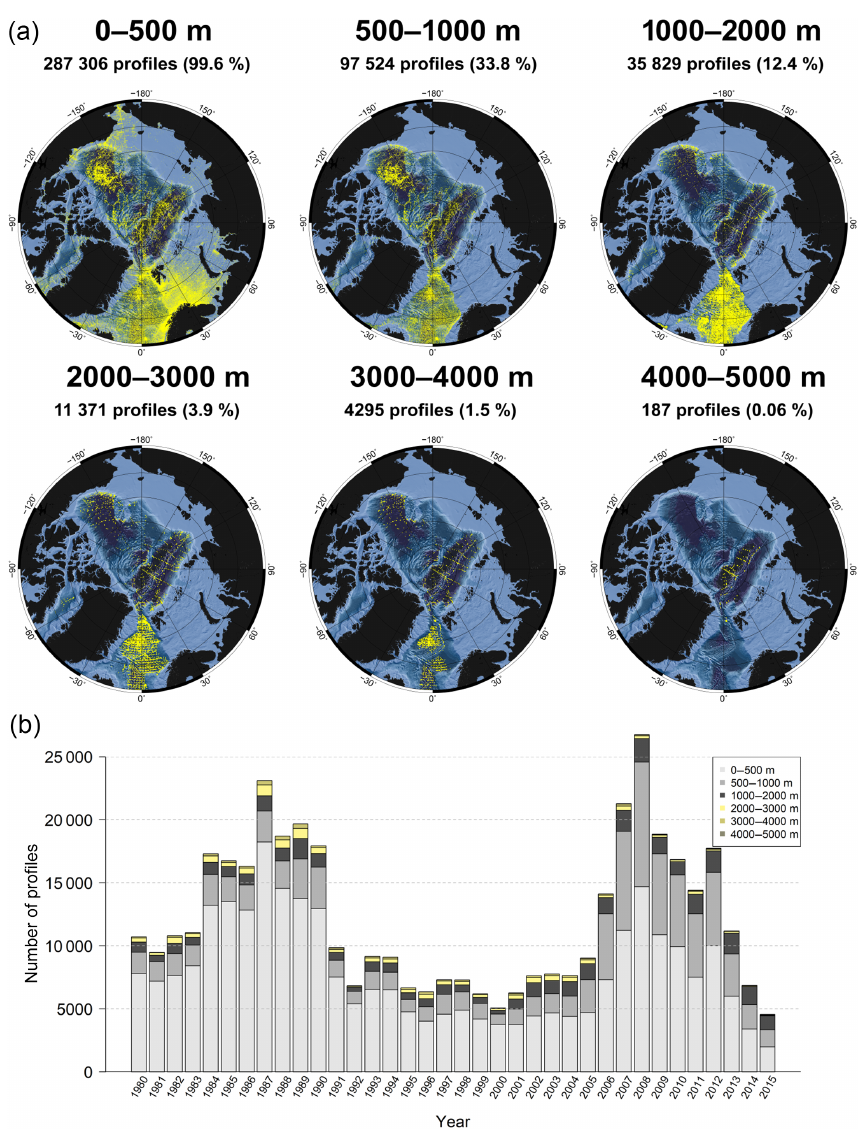
Figure 14. (a) Distribution maps of profiles with valid data in the shown depth ranges. The fraction of the full data set is shown as percentage in brackets behind the respective number of profiles. Note that the dot size varies, which makes the profile density appear higher in the Nordic Seas for the range 1000–2000m. The percentages sum up to more than 100% as one profile may contain data in more than one depth category. (b) Number of profiles per year, with valid data in different depth ranges